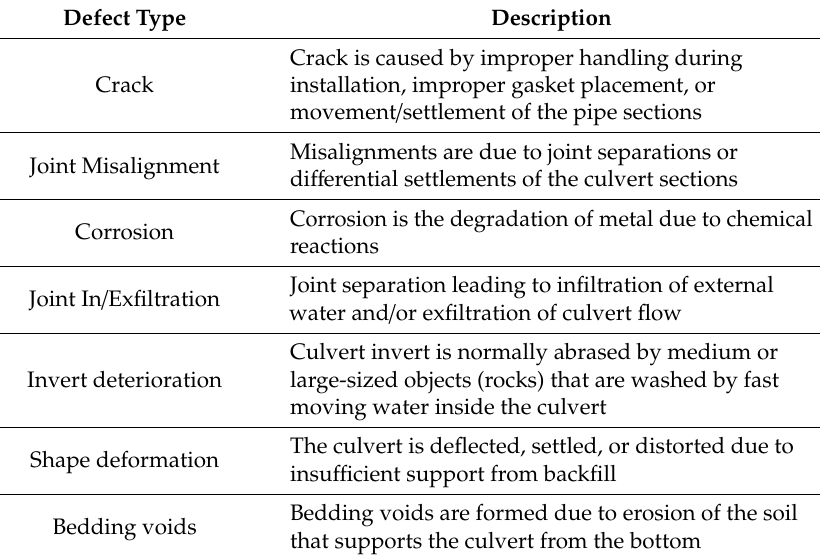
Table 4. Definitions of defects commonly observed on culvert barrels.